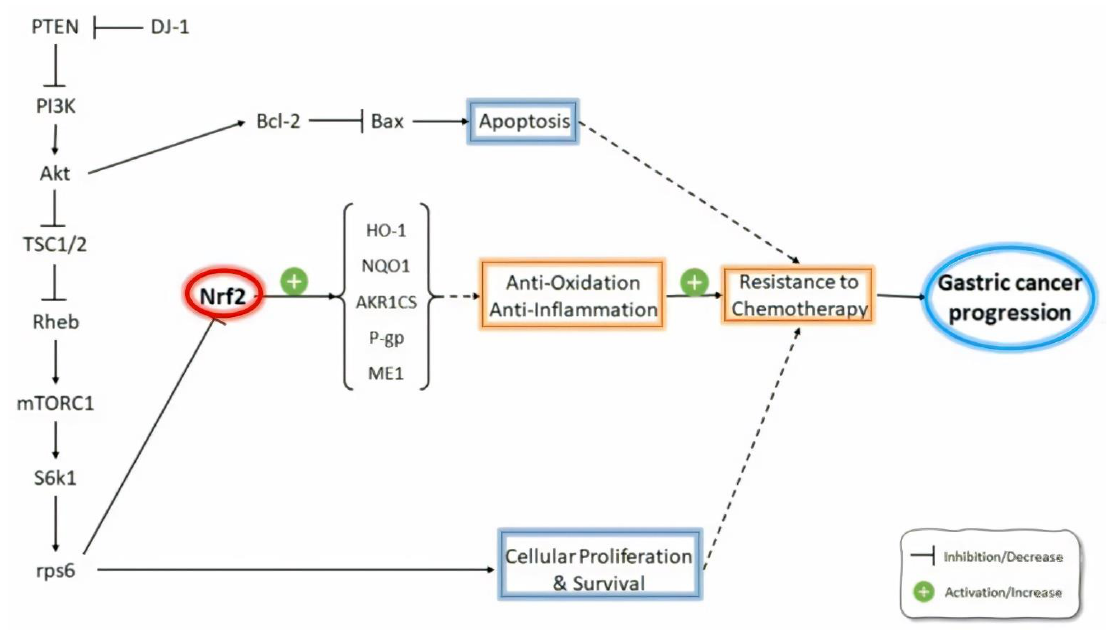
Figure 2. Role of Nrf2 pathways in gastric cancer.